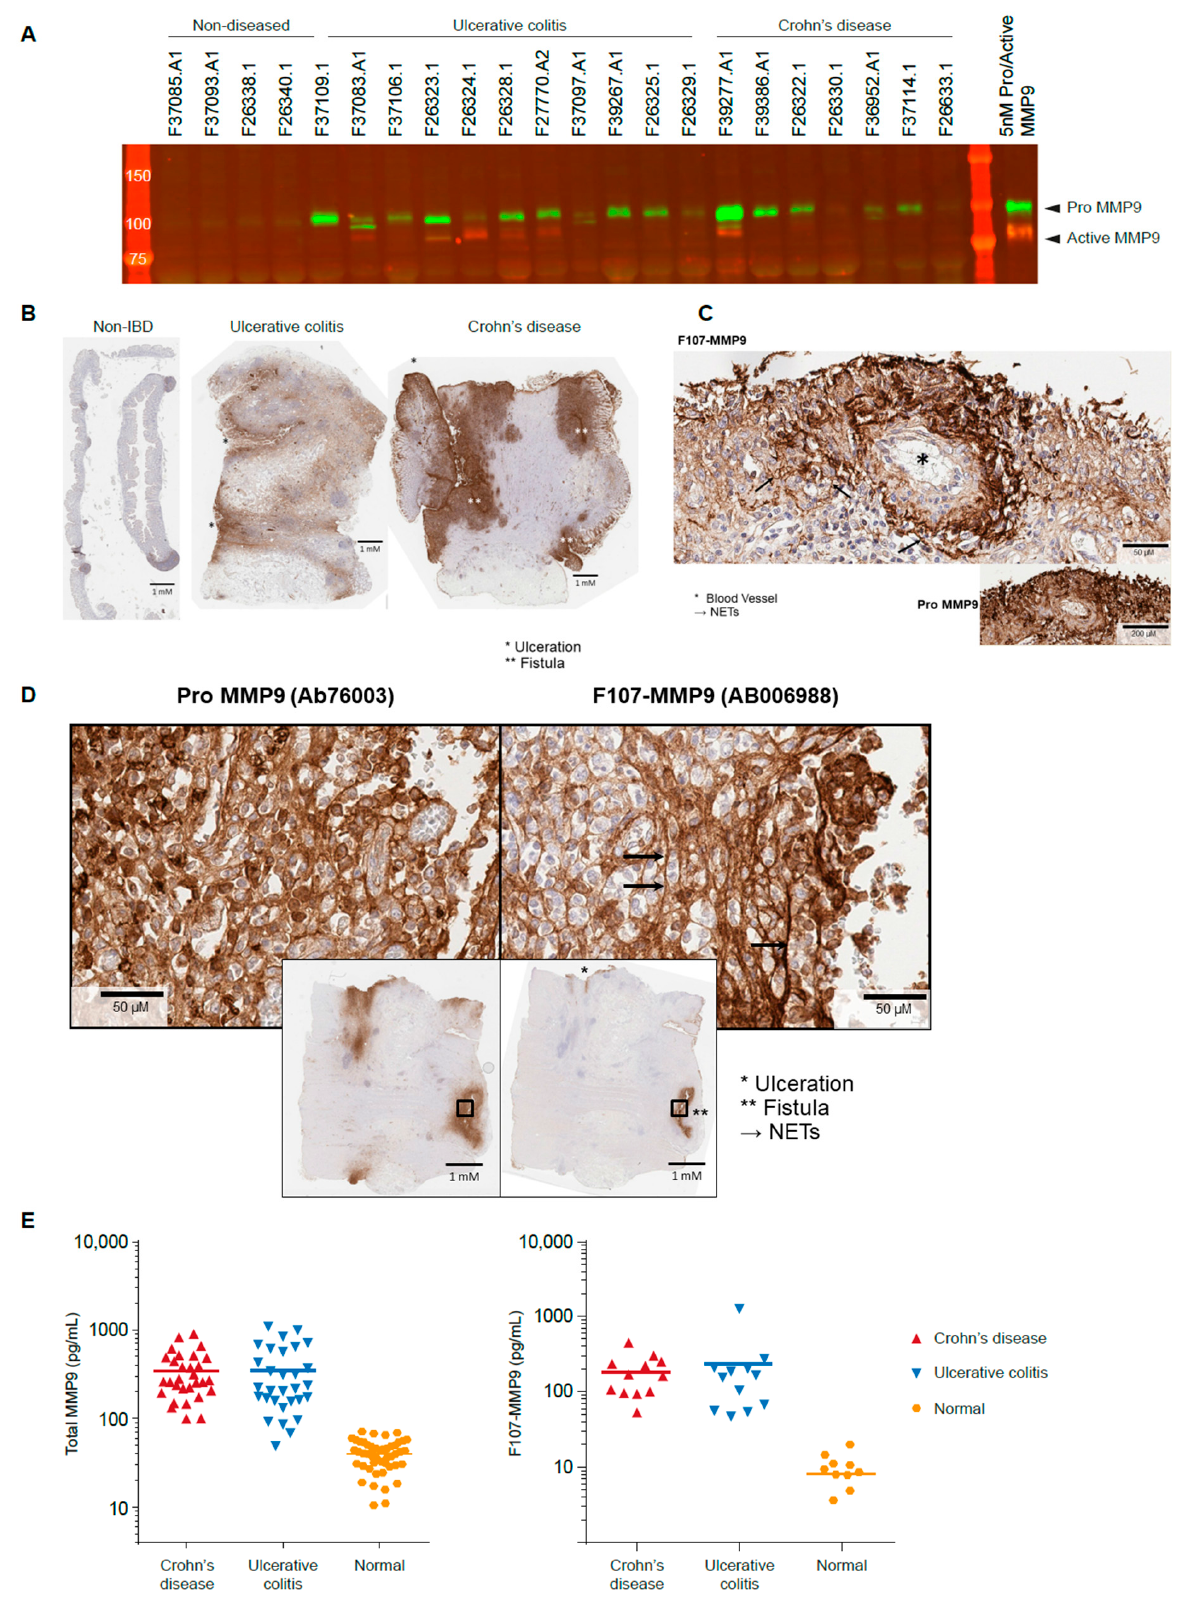
Figure 3. Pro- and active MMP9 in human IBD specimens. ( A ) Homogenized colon tissue from patients with ulcerative colitis and Crohn’s disease contain distinct levels of pro-MMP9 and active MMP9. ( B ) Pro-MMP9 is widespread in diseased colon tissue. ( C ) F107-MMP9 is focal and associated with diseased blood vessels and ( D ) fistulae. ( E ) Serum from patients with ulcerative colitis and Crohn’s disease contains higher levels of pro-MMP9 and active MMP9 than serum from healthy control donors. IBD, inflammatory bowel disease; MMP, matrix metalloproteinase; NETs, neutrophil extracellular traps.